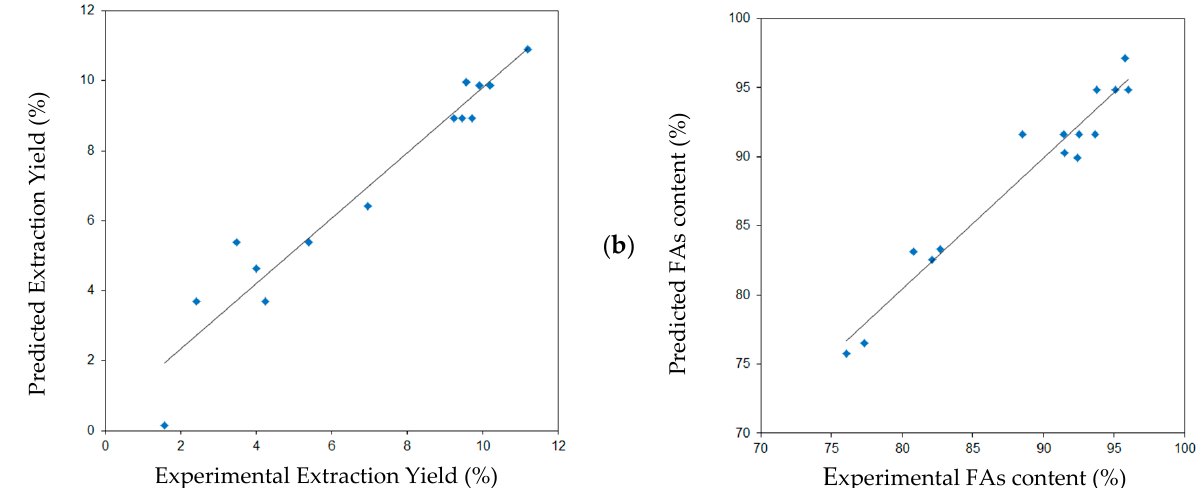
Figure 1. Comparison of the experimental results with the results predicted according to the developed mathematical models for: ( a ) the extraction yield (y = 0.9357x + 0.4571), ( b ) the content of fatty acids in the blackcurrant extract (y = 0.9506x + 4.3776). The figures below show the response surface